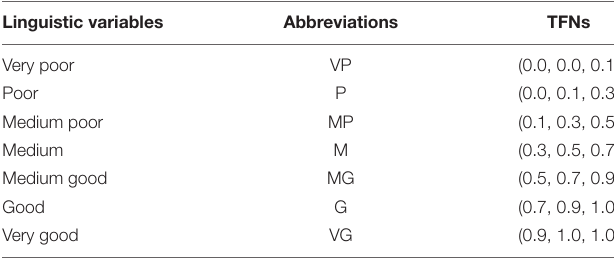
TABLE 1 | Fuzzy linguistic variable. Linguistic